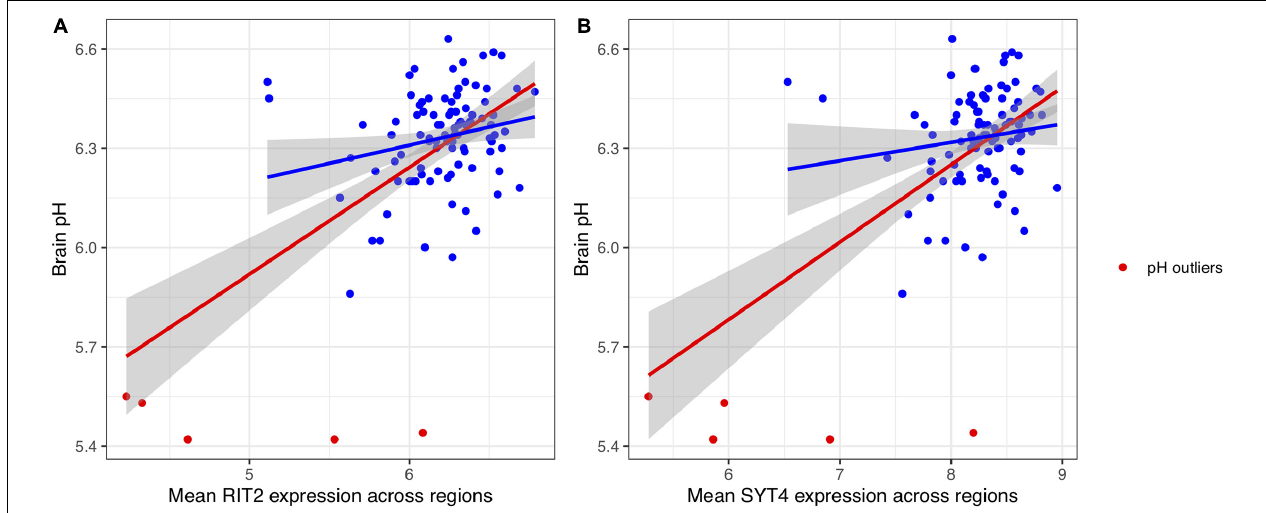
FIGURE 3 | Scatter plots of the relationship between pH with RIT2 (A) and SYT4 (B) gene expression. pH outliers are colored red. Lines representing linear fits with (red) and without outliers (blue) include shaded areas marking the 0.95 confidence intervals.